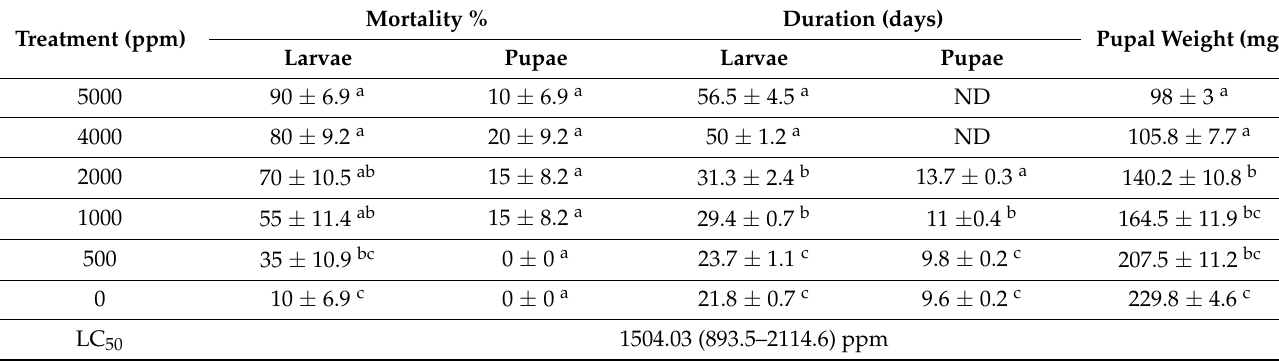
Average values ( ± SE) followed by the same letter are not significantly different ( p < 0.05, Tukey’s test). ND, no data because all individuals presented mortality of